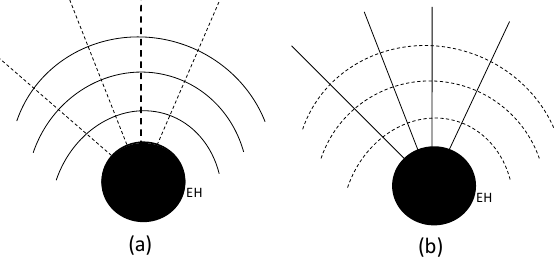
Figure 2. ( a ) Constant- r surfaces as leaves; ( b ) radial lines as